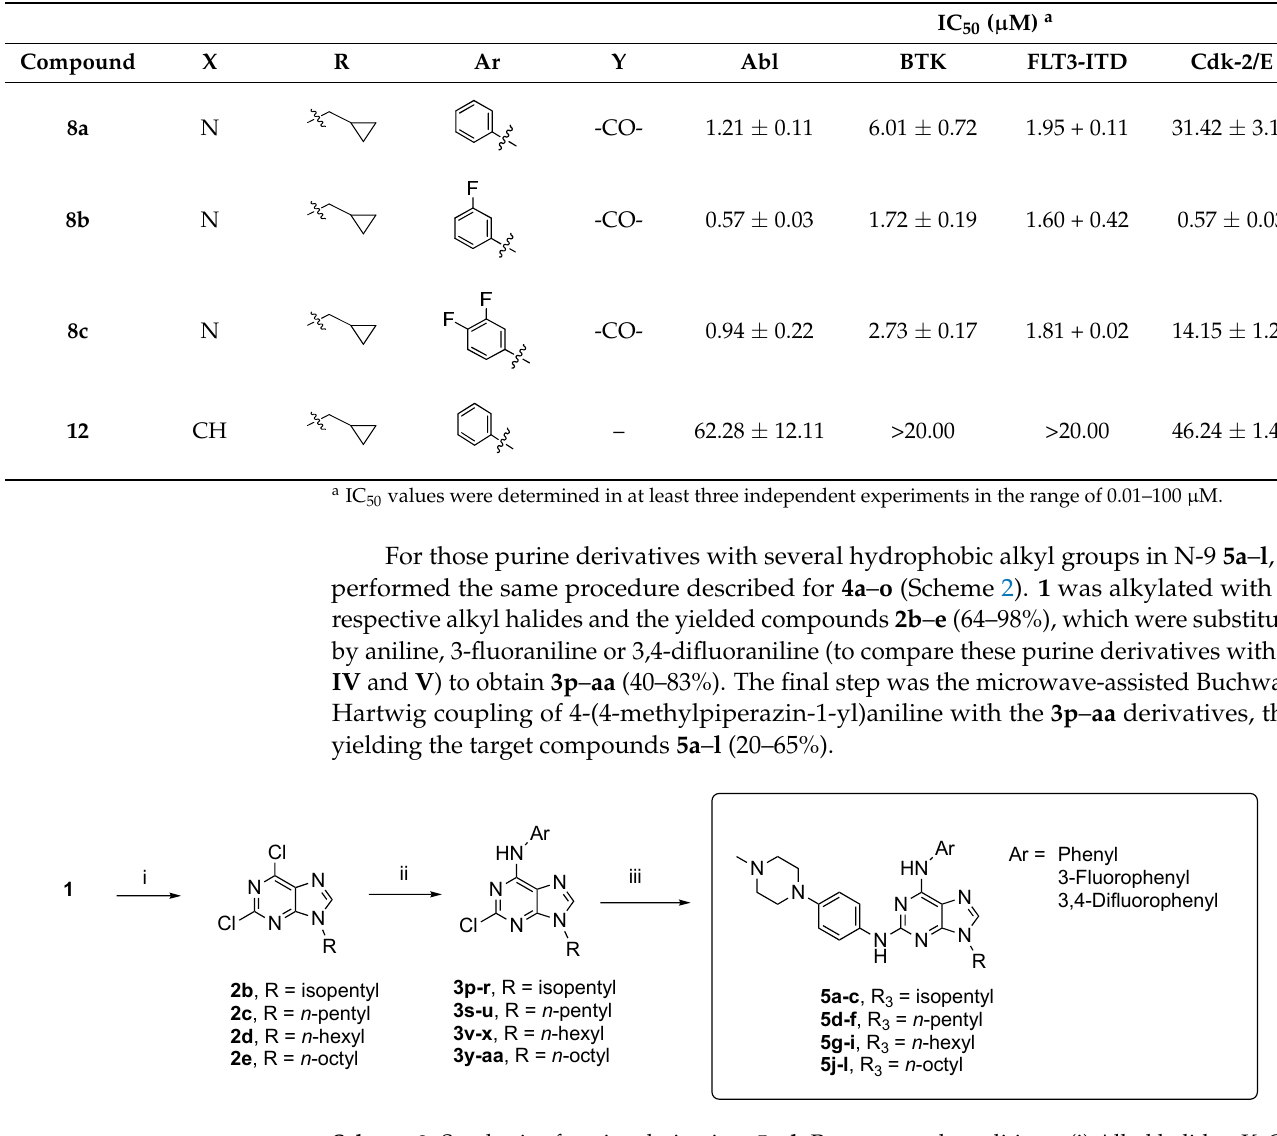
Scheme 2. Synthesis of purine derivatives 5a – l . Reagents and conditions : (i) Alkyl halides, K 2 CO 3 , DMF, 12 h, rt, 64 – 98% (ii) Anilines, DIPEA, n -butanol, reflux, 12 h, 40 – 83% (iii)